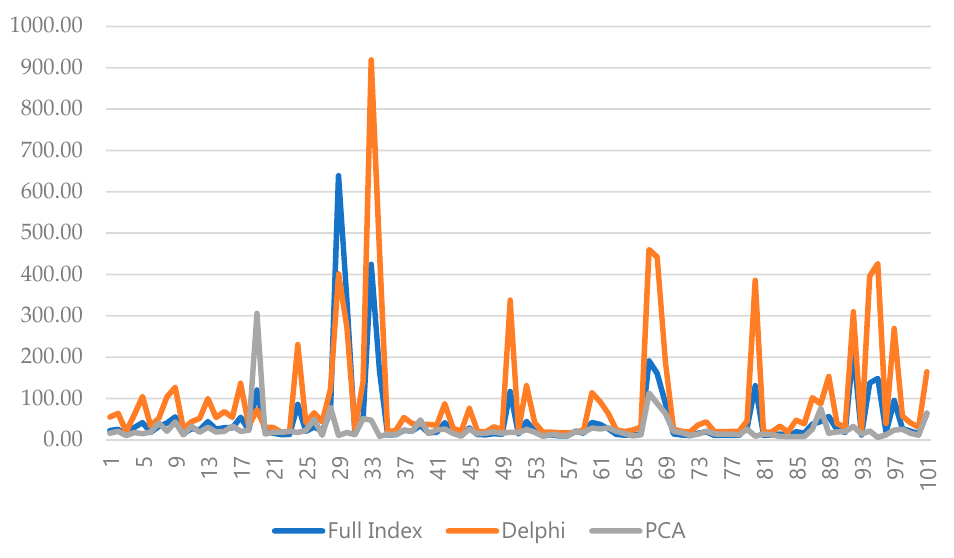
Figure 4. The comparison of WQI values by the three methods.